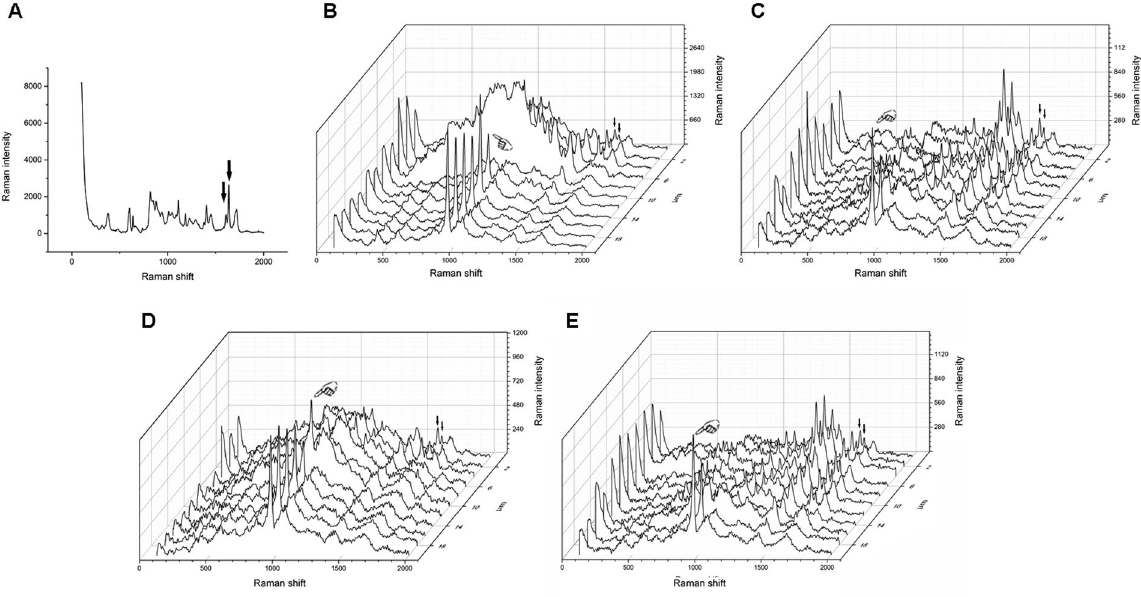
Figure 2. Micro-Raman spectrum acquired with SB2. ( A ) The representive spectrum of uncured SB2. The representive spectrum acquired with across the adhesive–dentine interface produced by cured SB2 of three groups: B-BC Group; C-NA Group; D, NEG Group; E, NE Group. In all figures, the first spectrum was collected in mineralized dentine: the finger indicated the PO 43 − group. The simultaneous decrease in the phosphate peak and increases in the adhesive peaks at 1608 cm − 1 and at 1640 cm − 1 (arrows) suggested the beginning of the hybrid